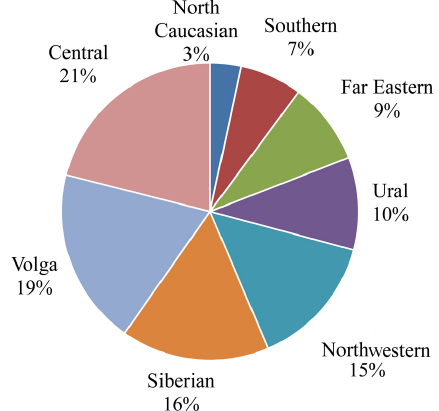
Figure 9. Emergencies distribution by federal districts of the Rus- sian Federation.